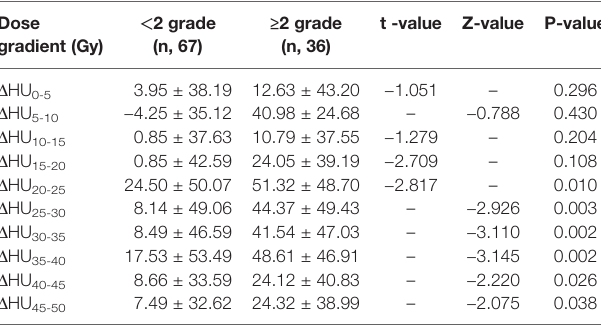
TABLE 5 | Comparison of the D Hu in different dose gradients between RP<2 grade and RP ≥ 2